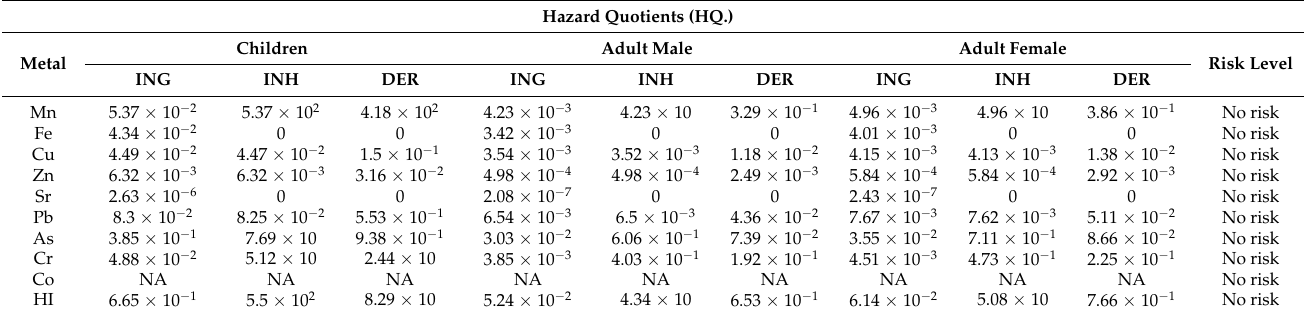
Table 7. Human health risk estimation for heavy metals contamination in soil collected from Kutubdia Channel, southern region, Bangladesh. Hazard Quotients